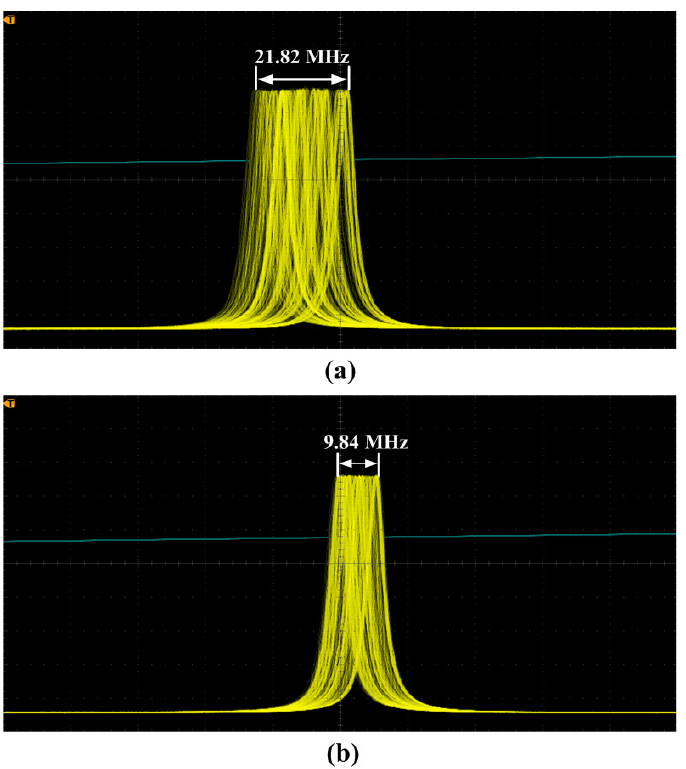
Figure 15. Frequency drift of 1064 nm laser in 1 min at two phases: ( a ) free-running phase and ( b ) controlled phase [29]. Reprinted with permission from [29] c (cid:13) The Optical